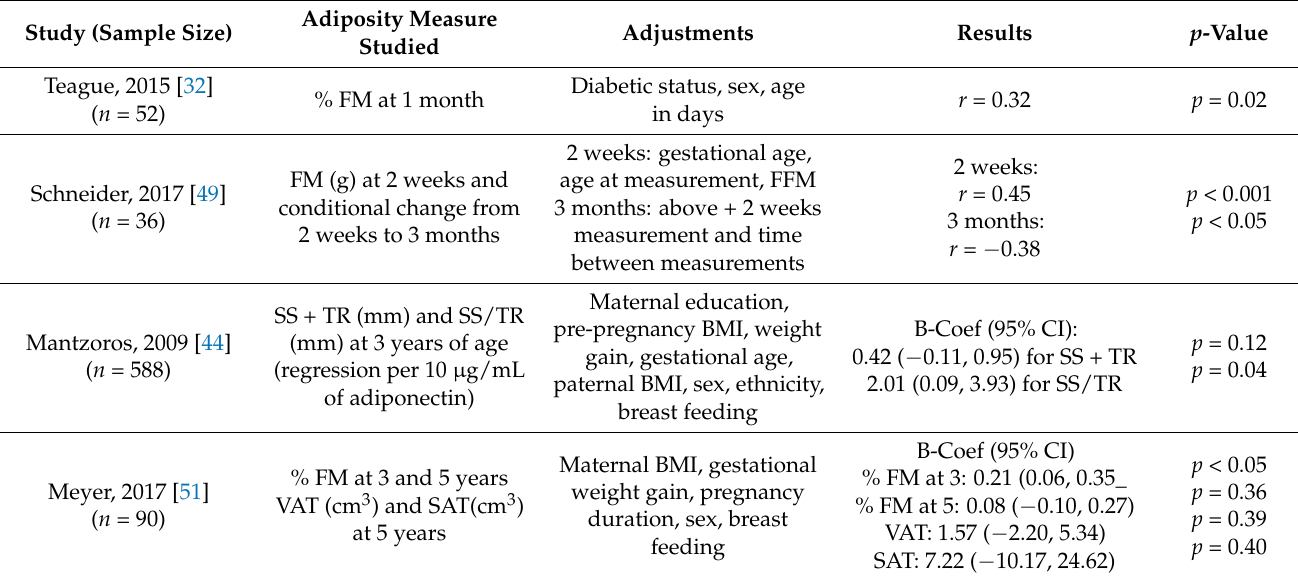
Table 3. Cord blood adiponectin and adiposity in early